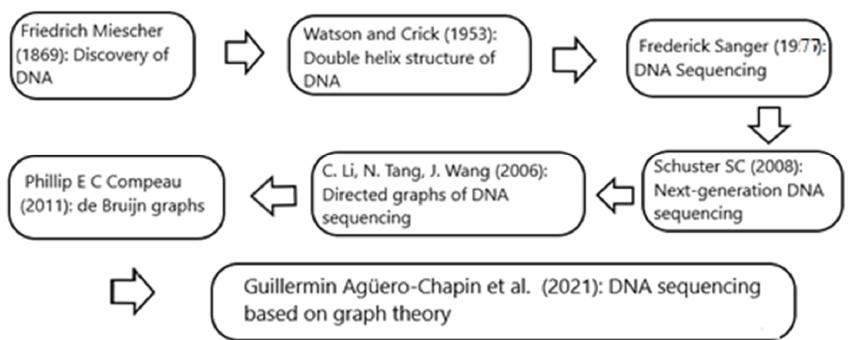
Figure 1. The history of DNA sequencing and double helix